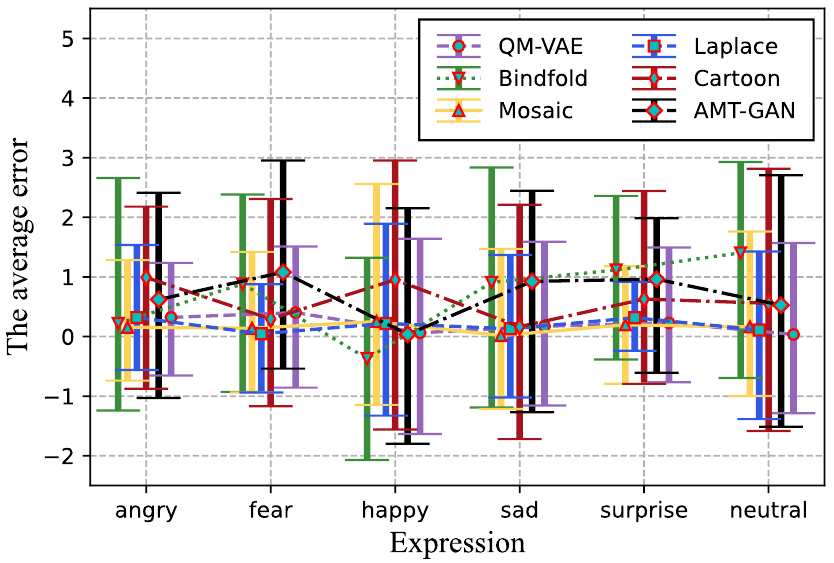
Figure 10. The error bar diagrams of de-identified image by different